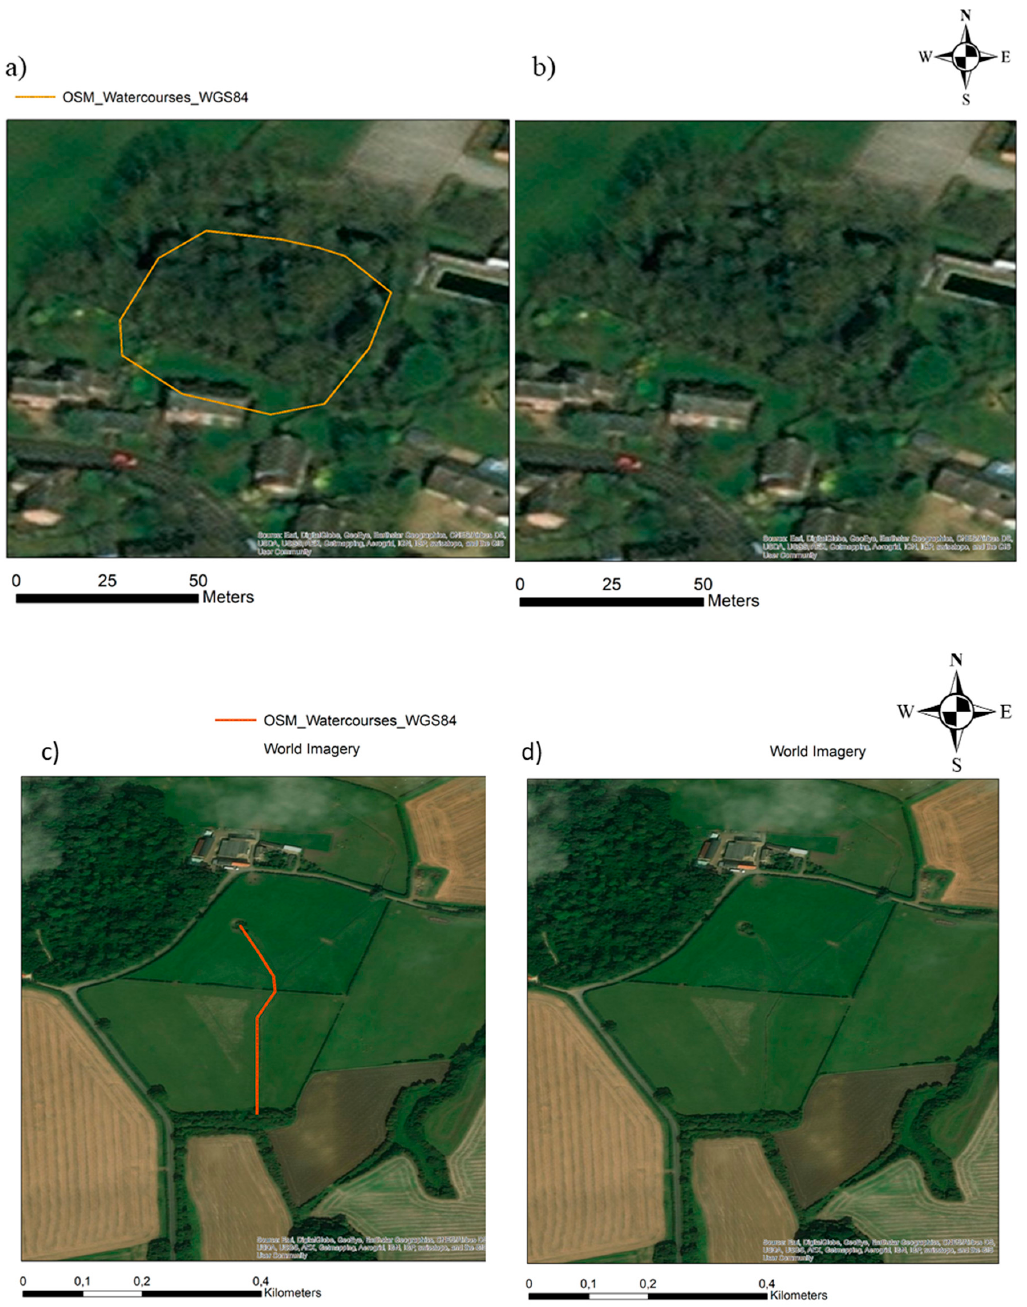
Figure 8. ( a , c ) show isolated OSM watercourses that were removed from the drainage network used to create the rebuilt DEM; and ( b , d ) show the image without these watercourses.